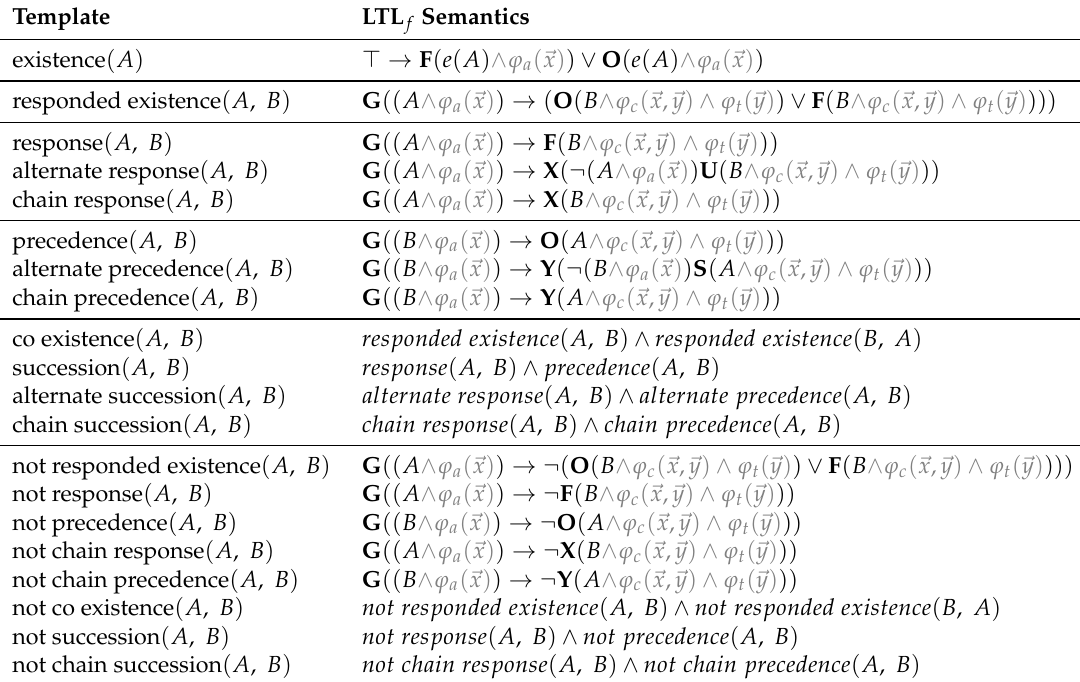
Table 1. Semantics for MP-Declare constraints in LTL f